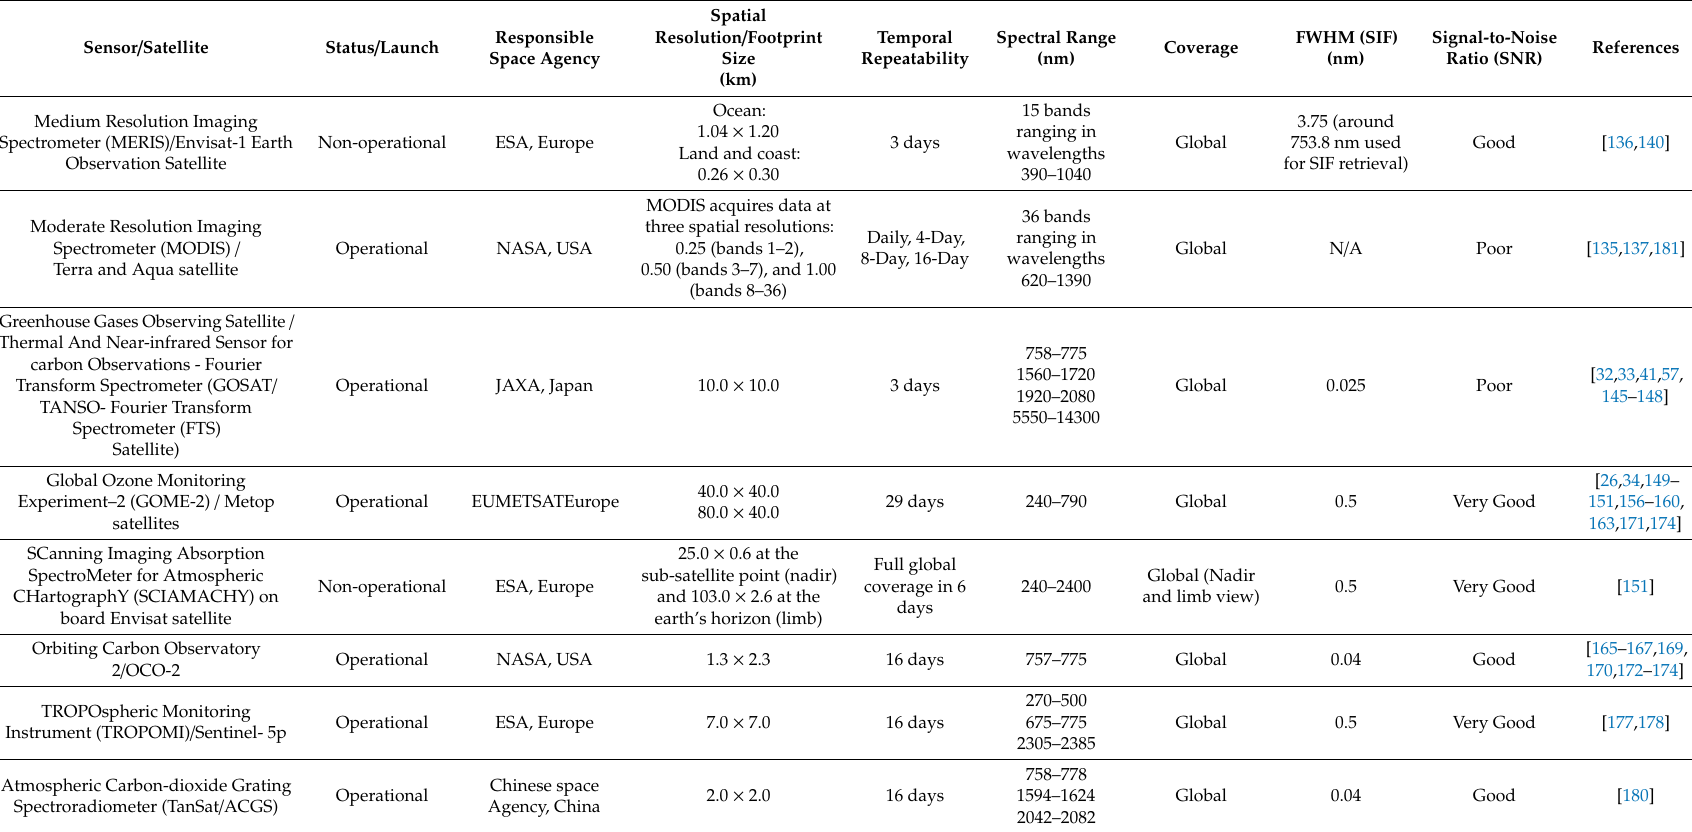
Table 5. Summary of the satellite platforms and systems used for SIF estimations until